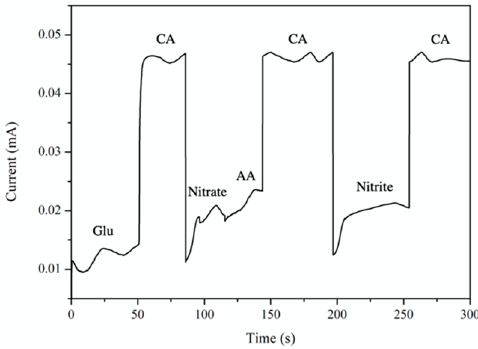
Figure 9. Chronoamperogram of the BaTiO 3 /MWCNT composite (2:1)-based electrode in 500 µM glutamate (Glu), 500 µM citric acid (CA), 500 µM nitrite, 500 µM ascorbic acid (AA), and 500 µM nitrite at an applied voltage of − 0.67 V.